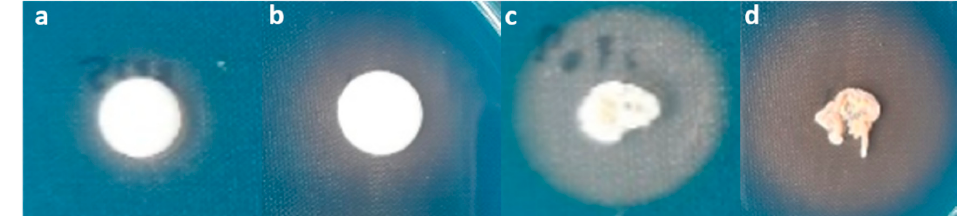
Figure 4. Siderophore production by ( a ) T. indica DMKU-RP31; ( b ) T. indica DMKU-RP35; ( c ) Ps.